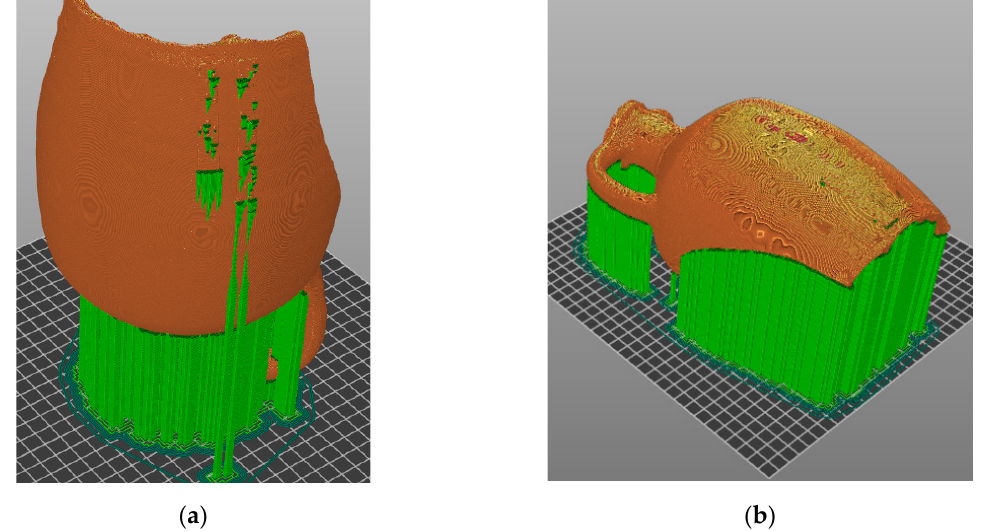
Figure 10. Preview of alternative ways of placing the object in the workspace, simulation in Slicer— Stage F (the green colour represents the supports): ( a ) placing the object in an inverted position upright; ( b ) placing the object in a horizontal position with the inscriptions facing up.